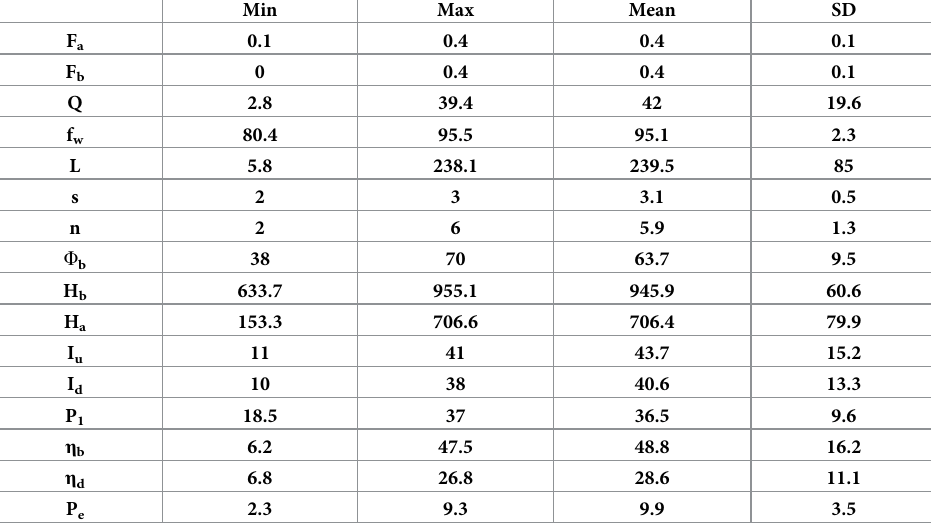
Table 2. Statistical value of 16 indicators in the